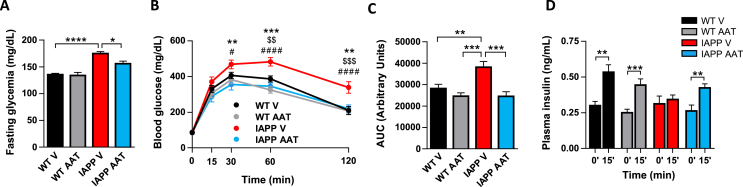
In vivo treatment with alpha1-antitrypsin (AAT) normalizes glucose homeostasis and improves insulin secretion in hIAPP-Tg mice. WT and hIAPP-Tg mice (IAPP) were treated intraperitoneally with vehicle (V) or AAT (2–6 mg/mouse) from 6 to 16 weeks of age. At the end of the treatment, different parameters related to glucose homeostasis were determined. (A) Glycemia after 5 h of fasting. (B–C) Intraperitoneal glucose tolerance test (IPGTT) in mice after 10 weeks of AAT or V intraperitoneal injections. Glycemia values and respective areas under the curve (AUC) are shown. ∗P < 0.05; ∗∗P < 0.01; ∗∗∗P < 0.001; ∗∗∗∗P < 0.0001 IAPP/V versus IAPP/AAT. $$ P < 0.01; $$$ P < 0.001 IAPP/V versus WT/V. #P < 0.05; ####P < 0.001 IAPP/V versus WT/AAT. (D) Plasma insulin levels at 0 min and 15 min after glucose injection. Results are expressed as the mean ± SEM from two independent experiments (n = 9–16 mice/group). ∗P < 0.05; ∗∗P < 0.01; ∗∗∗P < 0.001; ∗∗∗∗P < 0.0001.